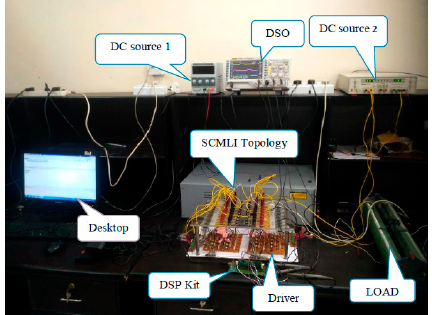
Appl. Sci. 2021 , 11 , x FOR PEER REVIEW Figure 14. Experimental setup. Figure 14. Experimental setup.